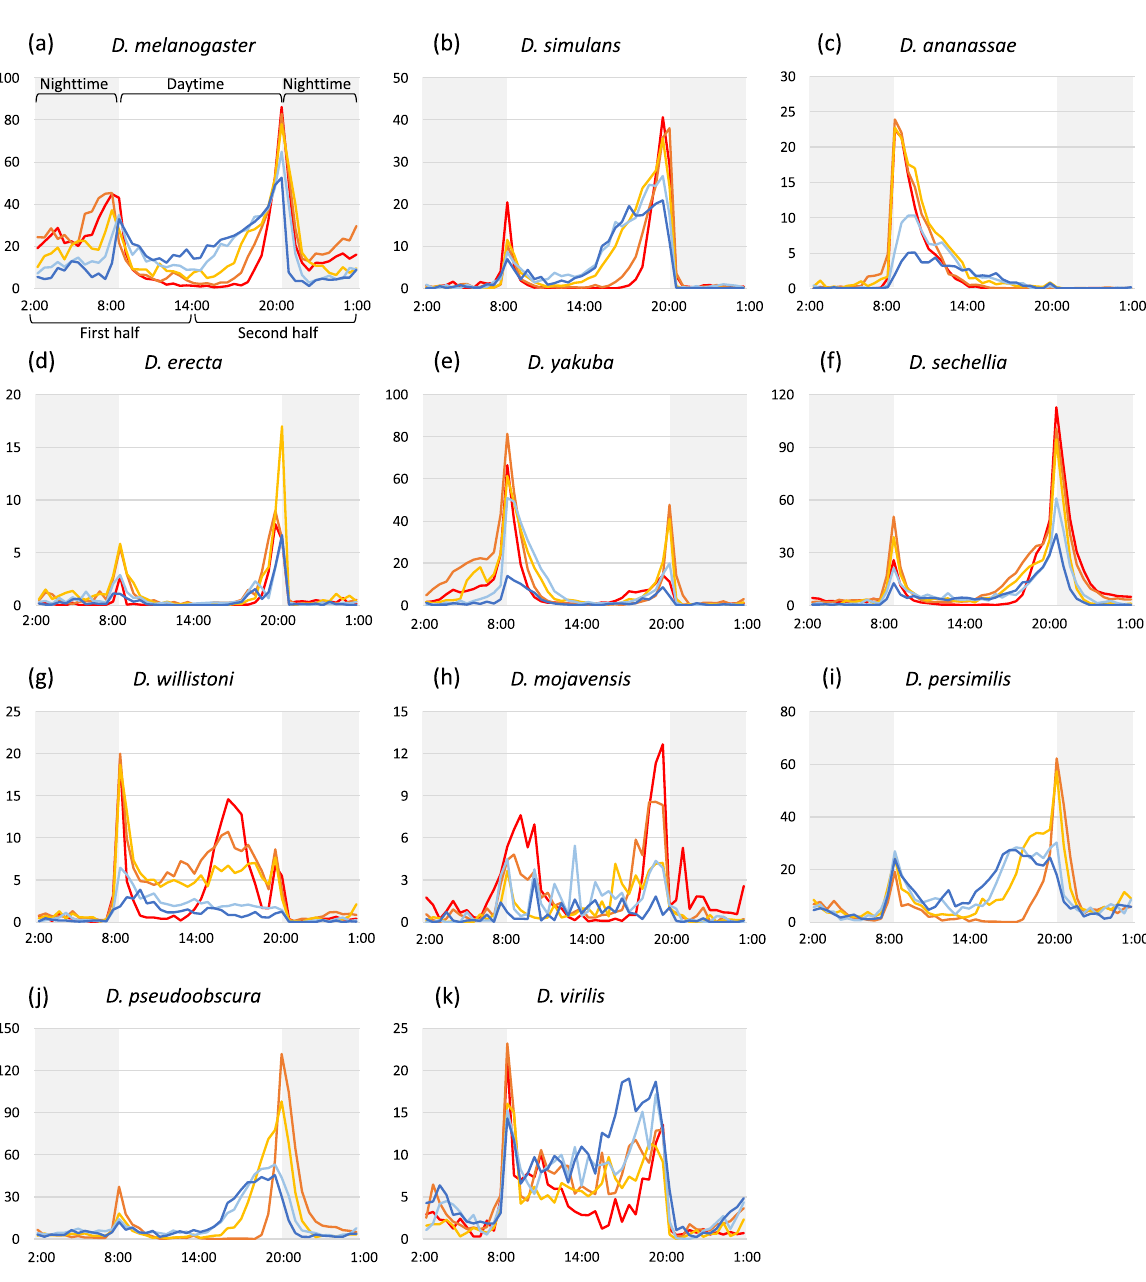
Figure 2. Profiles of daily locomotor activity in 11 Drosophila species at five different temperatures. ( a–k ) The profiles of daily locomotor activities in each species; ( a ) D. melanogaster , ( b ) D. simulans , ( c ) D. ananassae , ( d ) D. erecta , ( e ) D. yakuba , ( f ) D. sechellia , ( g ) D. willistoni , ( h ) D. mojavensis , ( i ) D. persimilis , ( j ) D. pseudoobscura , and ( k ) D. virilis . The y axis shows the activity levels (counts). Caution that the y axis range are different among species. The lines depict the average counts in 30 min at each temperature condition. The line color indicates experimental temperatures; dark blue:17 °C, light blue: 20 °C, light orange: 23 °C, dark orange: 26 °C, red: 29 °C. The shadow in the figure indicates the dark condition